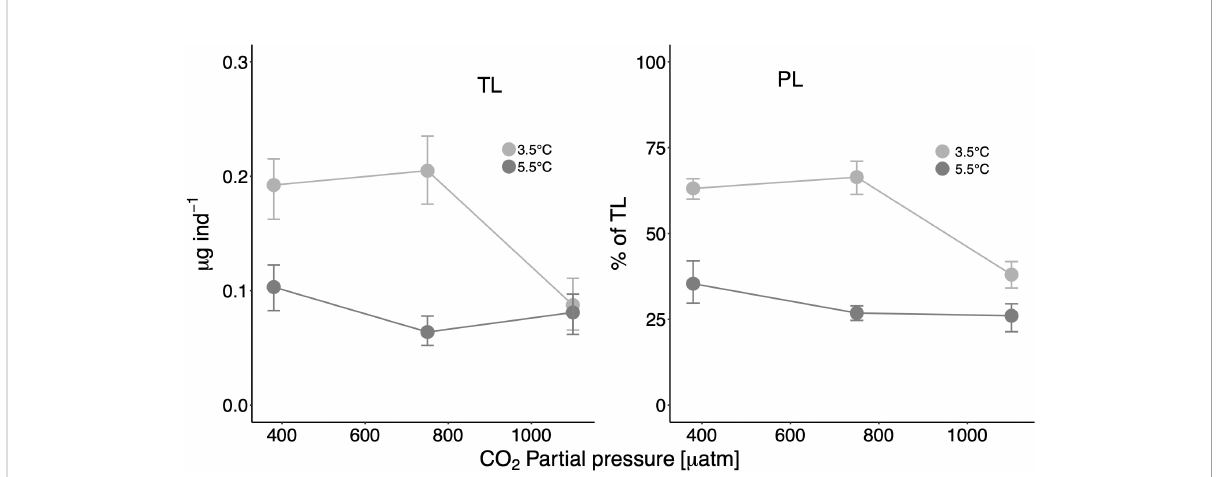
20:5(n − 3) higher than average in the high CO 2 treatment (Figure 6A), as well as the lipid class PI (Figure 6B).